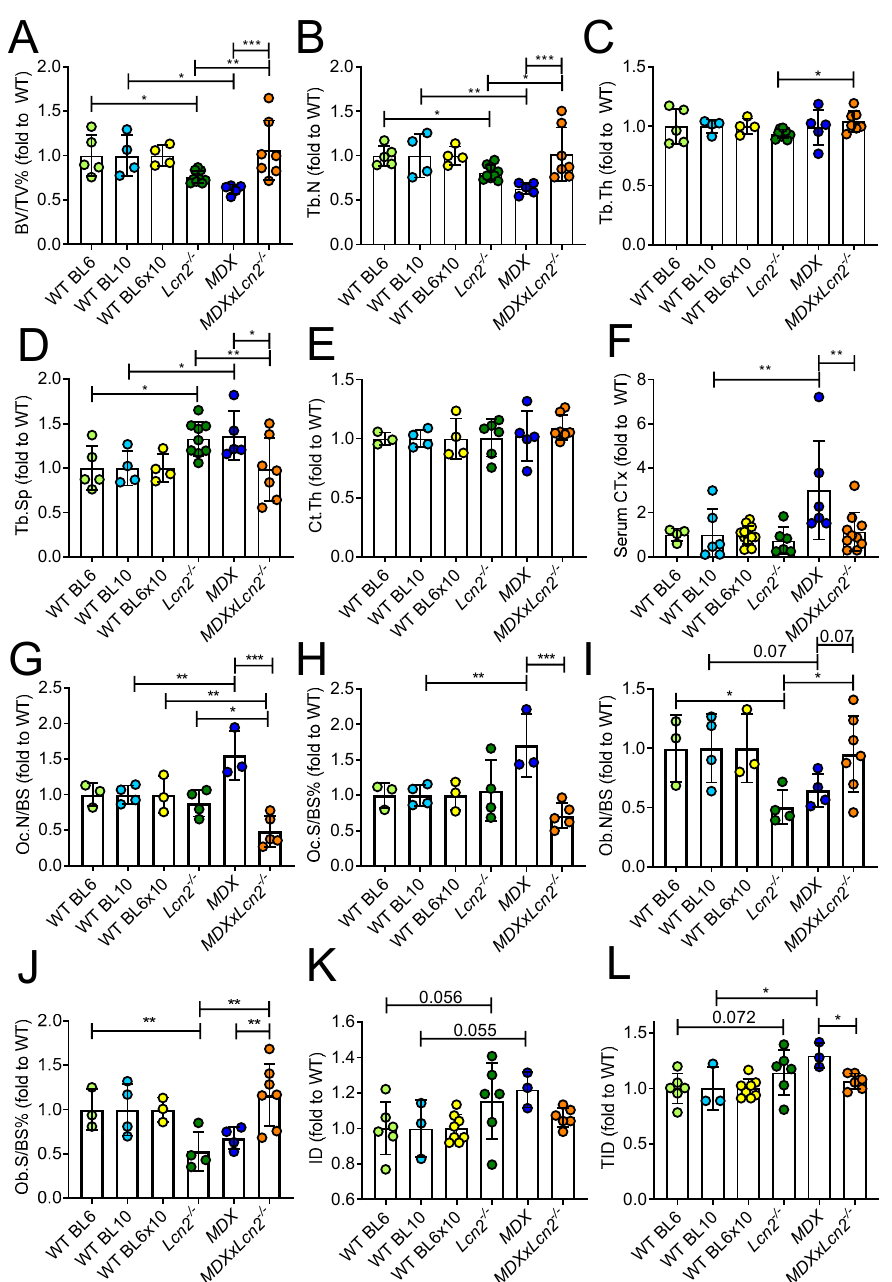
Figure 2. Effect of Lcn2 genetic ablation on the bone phenotype of 3-month-old MDX mice. ( A ) Mi- croCT analysis performed on proximal tibiae explanted from 3-month-old Lcn2 − / − , MDX, and MDX mice crossbred with Lcn2 − / − ( MDX x Lcn2 − / − ) and their respective WTs (BL6, BL10, and BL6x10, respectively) to evaluate trabecular bone volume/tissue volume (BV/TV%), ( B ) trabecular number (Tb.N), ( C ) thickness (Tb.Th), and ( D ) separation (Tb.Sp). ( E ) Tibial cortical bone thickness (Ct.Th). ( F ) Serum analysis of carboxy-terminal collagen crosslinks (CTx). ( G ) Histomorphometric analysis of tibia sections to evaluate osteoclast number/bone surface (Oc.N/BS) and ( H ) osteoclast